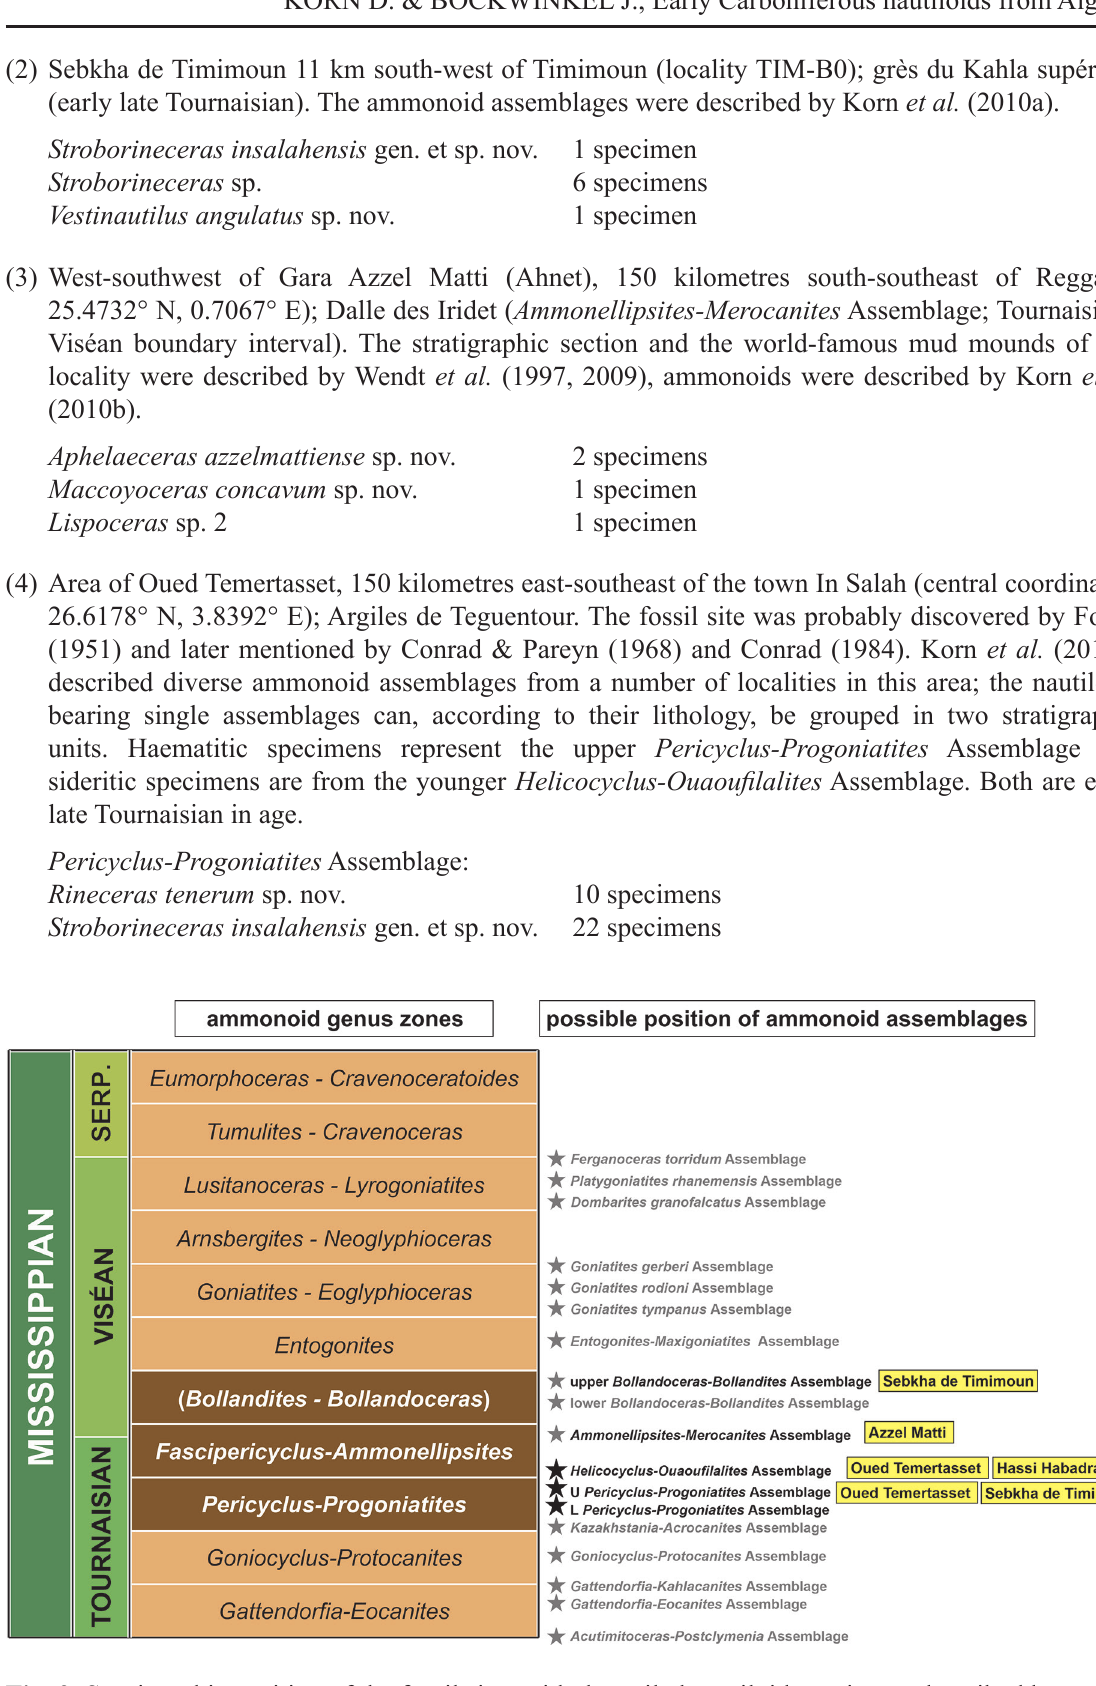
Fig. 2. Stratigraphic position of the fossil sites with the coiled nautiloid specimens described